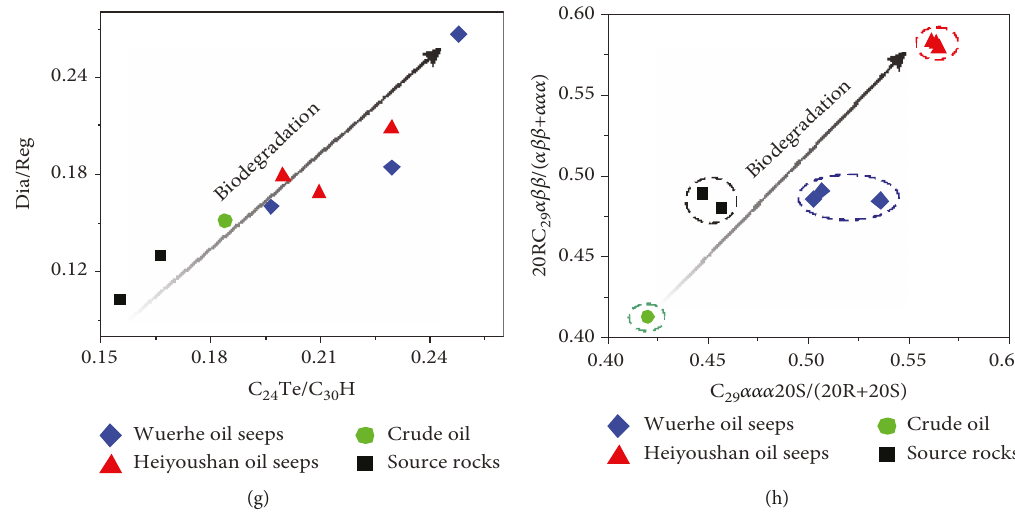
Figure 5: Plots of selected molecular geochemical parameters for oil-seep, crude-oil, and source-rock samples from the northwestern Junggar Basin. (a) δ 13 C (in ‰ relative to the VPDB standard) vs. SA/SARA; (b) C T/C T vs. C Te/C T; (c) C T/C T vs. C T/C T; (d) Ts/Tm 19 20 24 26 20 21 21 23 ααα 20R vs. C ααα 20R; (g) C ααα 20S/(20R+20S) vs. C αββ /( αββ + ααα ); (h) vs. G/C H; (e) C H/C H vs. C S/C S; (f) C /C /C 30 29 30 35 34 27 28 28 29 29 29 Te/C H vs. Dia/Reg. Abbreviations: SA =saturates+aromatics in %; SARA=saturates+aromatics+resins+asphaltenes in %; T =tricyclic C 24 30 terpane; Te =tetracyclic terpane; G=gammacerane; H=hopane; S =22S hopane; Dia =diasteranes; Reg=regular steranes. Data from Table